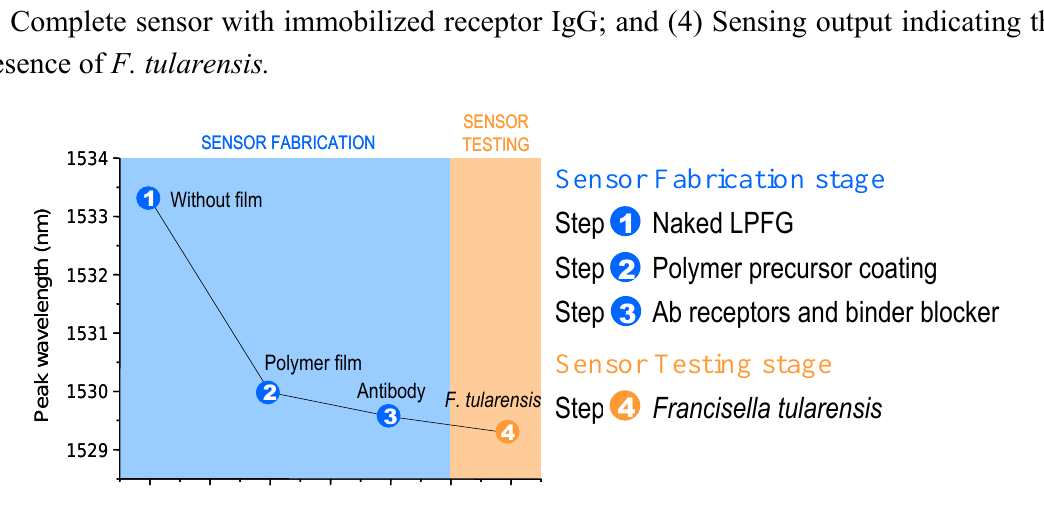
Figure 4. LPFG output wavelength change during film fabrication and sensing validation, indicating the peak wavelength (or output signal) at each step during sensor testing: